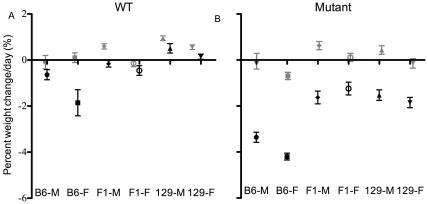
ATP8B1 mutant B6 mice lose substantial weight upon cholate feeding.Weight change per day in WT (A) and ATP8B1 mutant (B) mice of B6, 129, and F1 backgrounds after feeding of control (grey) or cholate (black) diet for 4–8 days; means and SEM are shown. N's for cholate diet: B6 (n = 8−13), 129 (n = 18−35), and F1 (n = 13−18); and control diet: B6 (n = 5−9), 129 (n = 22−29), and F1 (n = 11−16).